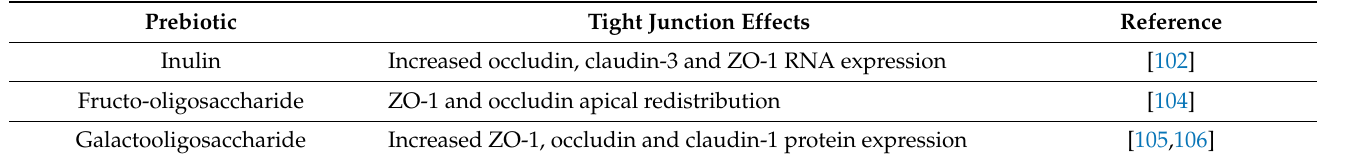
Table 2. Select prebiotics target TLRs and proposed beneficial effects on intestinal tight junctions.